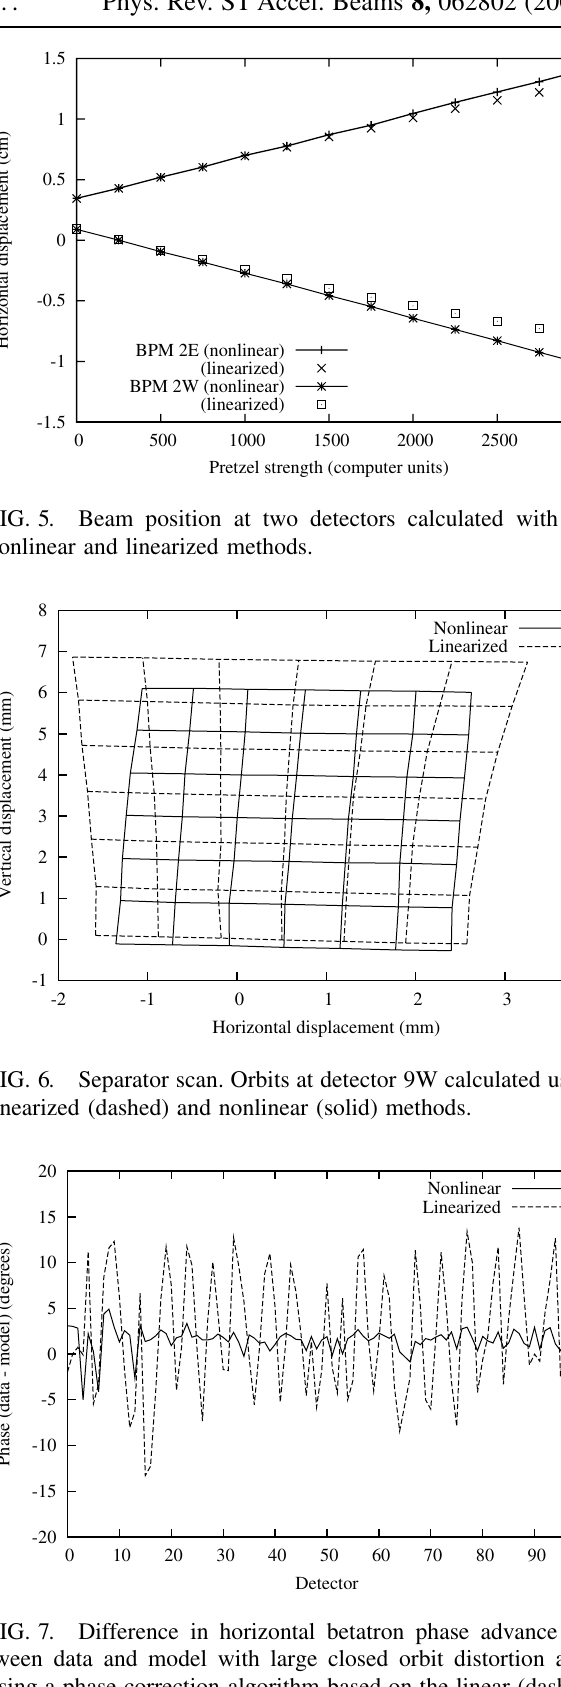
FIG. 4. Measured and calculated dispersion.